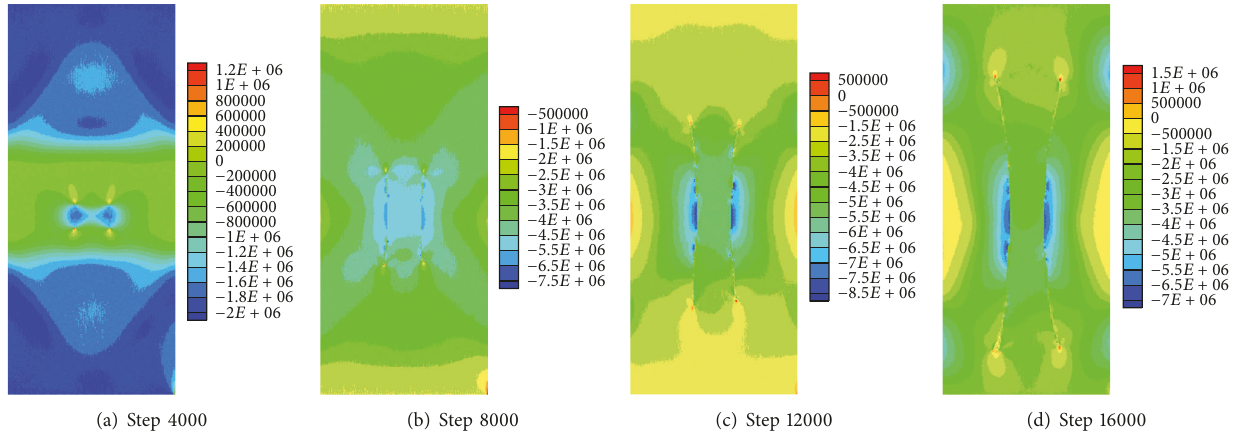
Figure 25: Maximum principal stress contours under an anisotropic in situ stress field (positive denotes